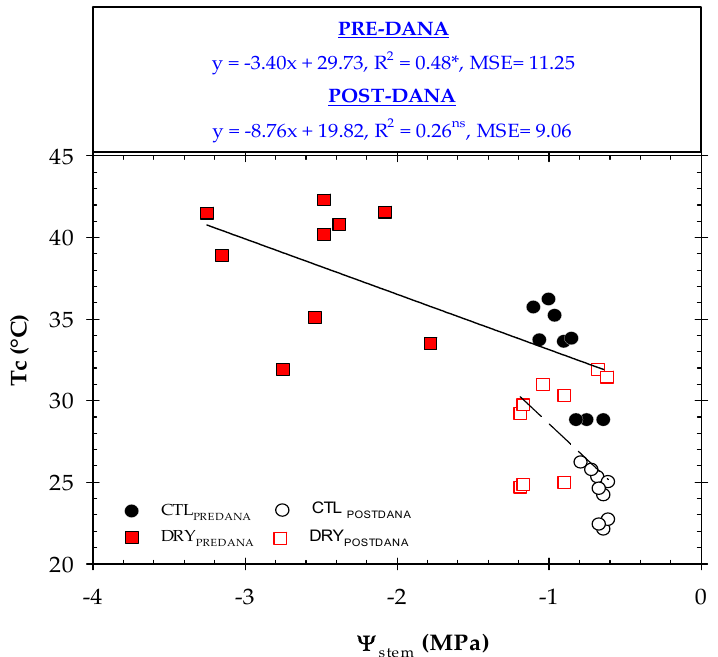
Figure (cid:561) 8. (cid:561) The (cid:561) relationship (cid:561) between (cid:561)(cid:794) stem (cid:561) and (cid:561) Tc (cid:561) in (cid:561) CTL (cid:561) (circles) (cid:561) and (cid:561) DRY (cid:561) (squares) (cid:561) treatments (cid:561) be (cid:556) Figure 8. The relationship between Ψ stem and Tc in CTL (circles) and DRY (squares) treatments before fore (cid:561) and (cid:561) after (cid:561) the (cid:561) DANA, (cid:561) respectively. (cid:561) Tc–Ta (cid:561) values (cid:561) correspond (cid:561) to (cid:561) the (cid:561) average (cid:561) measurements (cid:561) taken (cid:561) and after the DANA, respectively. Tc − Ta values correspond to the average measurements taken between (cid:561) 12:00 (cid:561) and (cid:561) 14:00 (cid:561) GMT (cid:561) + (cid:561) 0. (cid:561) Linear (cid:561) regression (cid:561) and (cid:561) R 2 (cid:561) are (cid:561) included (cid:561) in (cid:561) the (cid:561) graph. (cid:561) MSE (cid:561) means (cid:561) between 12:00 and 14:00 GMT + 0. Linear regression and R 2 are included in the graph. MSE means mean (cid:561) squared (cid:561) error. (cid:561) *: (cid:561) p <0.05, (cid:561) ns: (cid:561) not (cid:561) significant. (cid:561) (cid:561) mean squared error. *: p < 0.05, ns: not